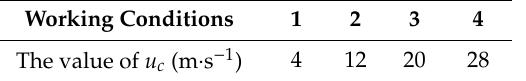
9 of 19 Figure 7. Dimensionless flow coefficient of the DACC as a whole at different velocities. 3. Results and Discussion The crosswind has great effect on the thermal-flow performances of DACCs. The reason for the frozen phenomena in the finned-tube radiators of the DACC is that when the ambient temperature is too low, the heat dissipation capacity of finned-tube radiators will increase. When the surface temperature of the finned-tube radiator is lower than the freezing point, the frozen phenomena will be formed. Crosswind is closely related to the heat dissipation capacity of the DACC. Therefore, there is a close relationship between frozen phenomena and crosswind. The average crosswind speed obtained from the Inner Mongolia Meteorological weather station in winter is about 4.2 m·s − 1 , and